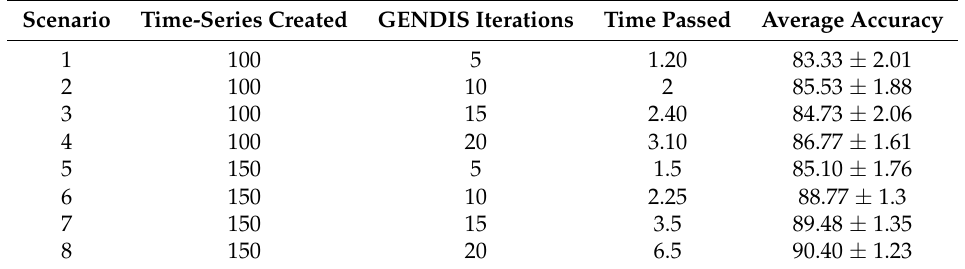
Table 2. Results for the “Steps vs. Random” scenarios. The average accuracy scores are reported in the 95% confidence